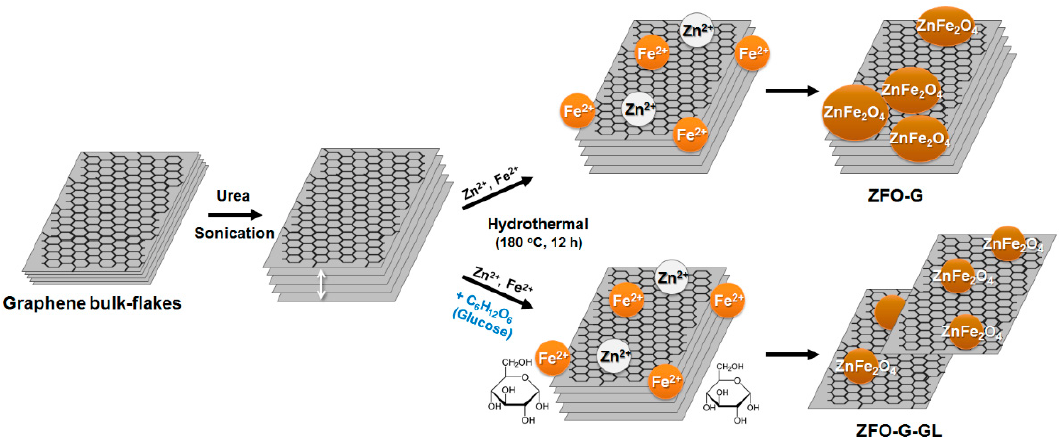
Figure 1. Preparation procedure of conventional ZnFe 2 O 4 /graphene (ZFO–G) and well-dispersed ZnFe 2 O 4 /graphene by using glucose ZnFe 2 O 4 /graphene by using glucose (ZFO–G–GL).